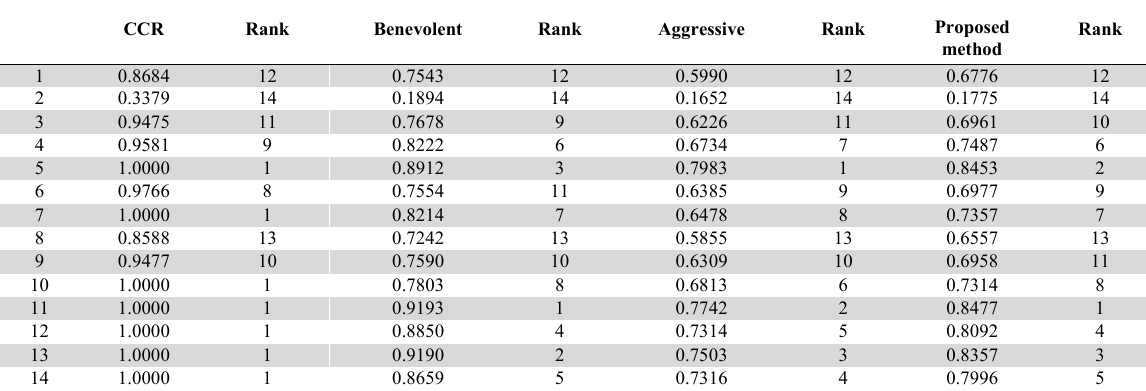
Step 3: Calculate the weights of DMUs and then rank all DMUs for fourteen international passenger airlines θ can be obtained using the same Step 3 of Section 4.1. The results are shown in After obtaining the w j of all criteria, i Table 13. Finally, r s was tested using Spearman’s rank correlation as listed in Table 14. The ranking of DMUs for fourteen international passenger